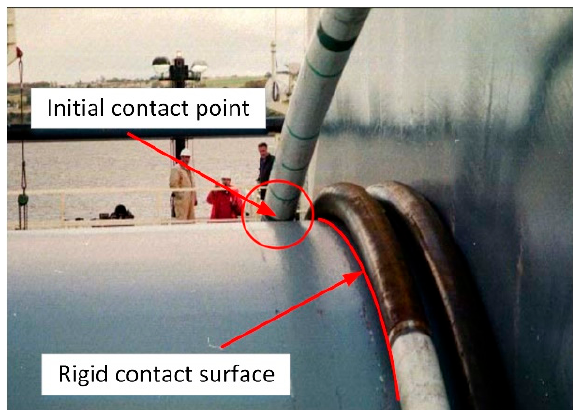
Figure 1. Principle of pipe reeling.